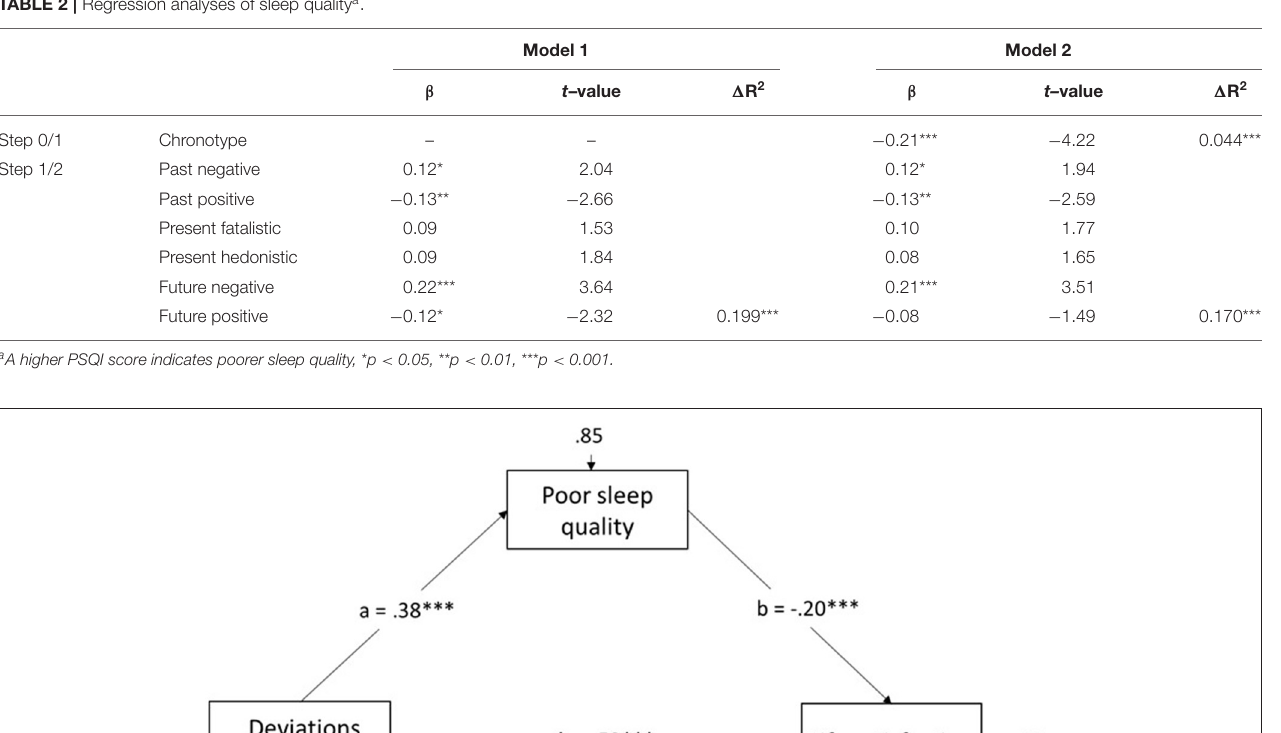
TABLE 2 | Regression analyses of sleep quality a .